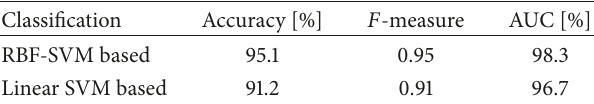
Table 1: The SVM based classification results after the cross-